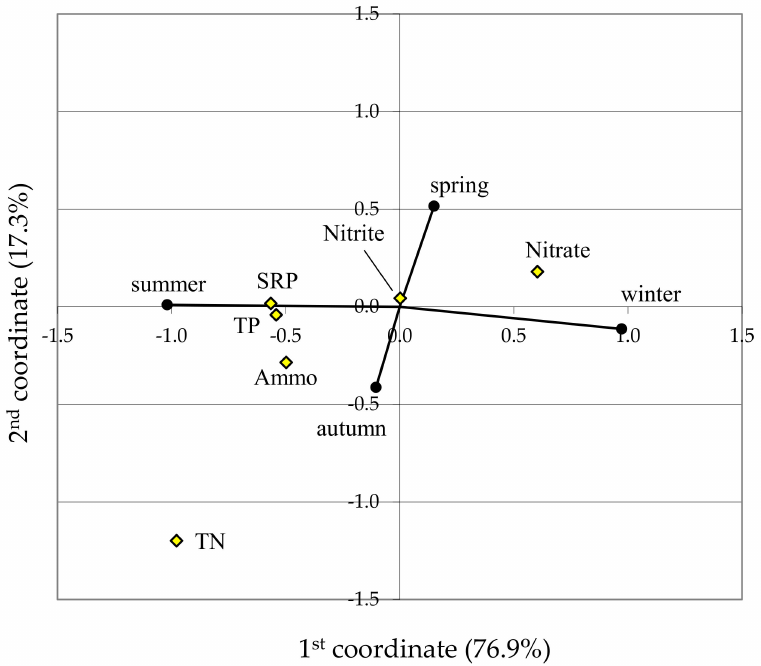
Figure 11. Position of measuring series determined by trophic parameters in the space of the first two canonical varieties and spacing of these parameters in the dual space (trait coordinates rescaled and multiplied by